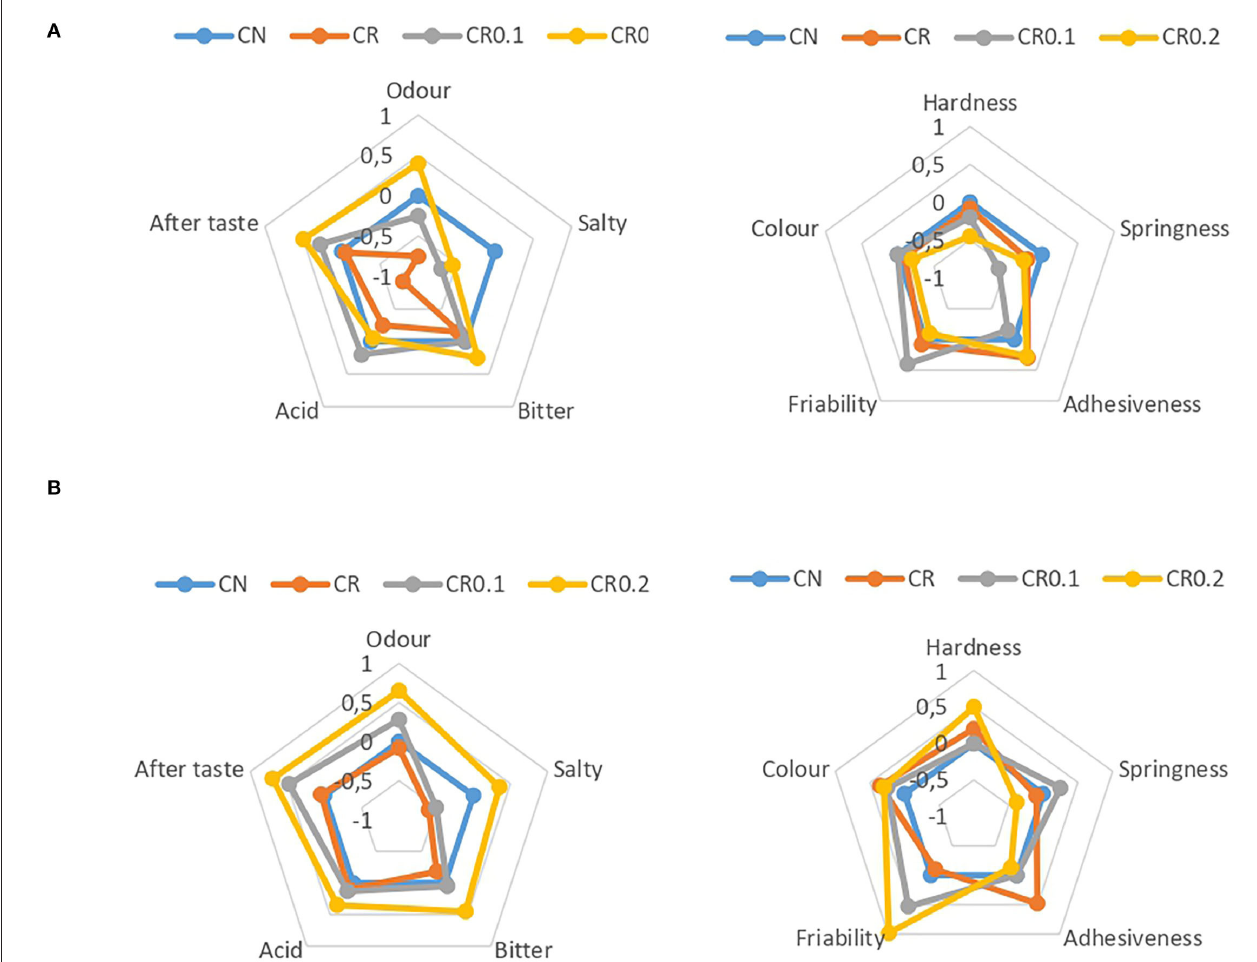
FIGURE 1 | Results of sensorial analysis of reduced-sodium (Na) cheeses by reduced-Na treatment (CR) at 30 days (A) and 60 days (B) of ripening.